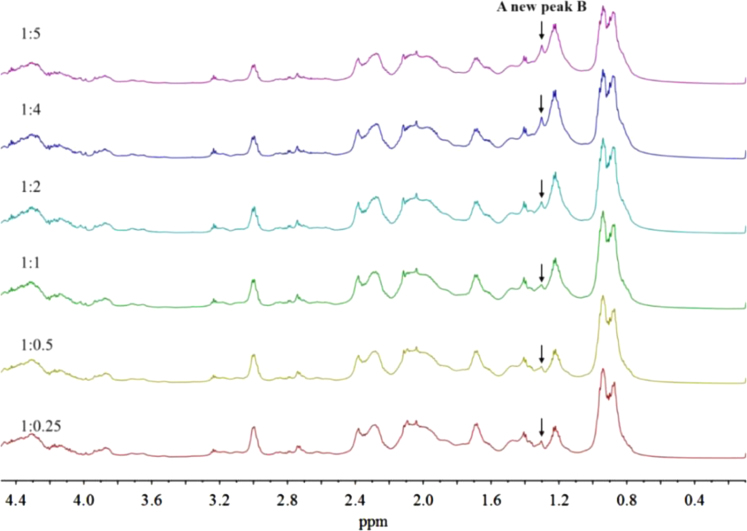
Stacked 1H NMR spectra of C14-caseinate.